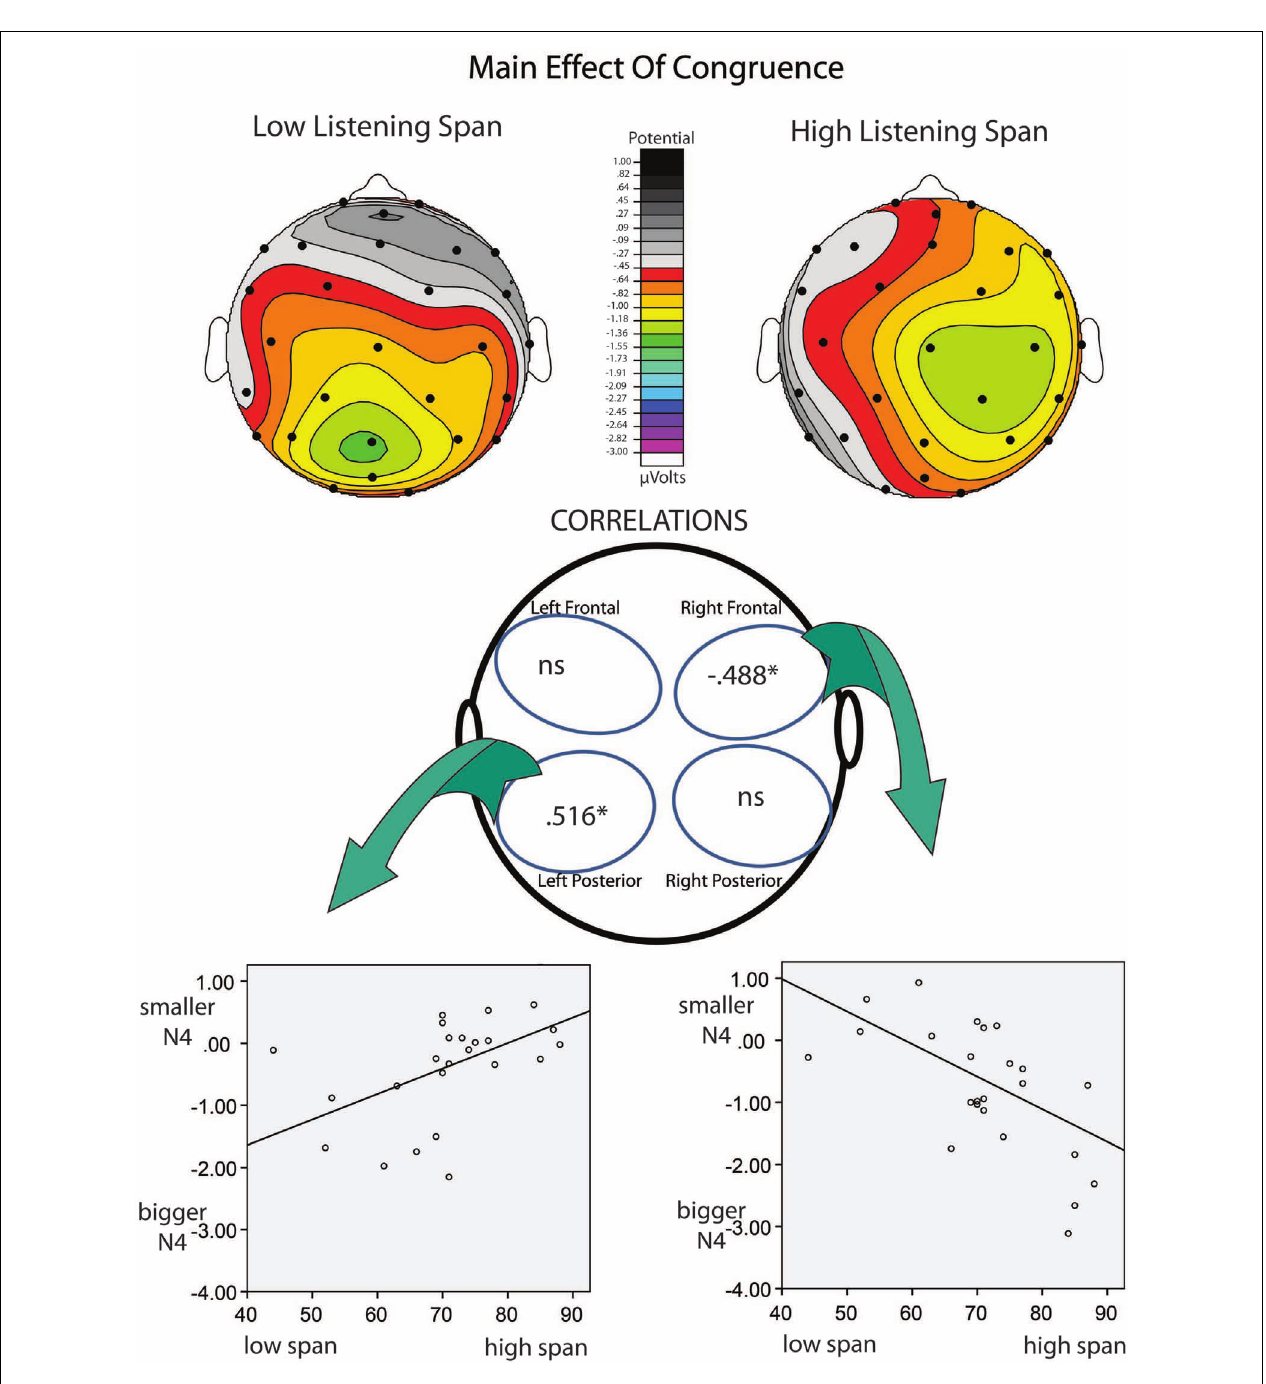
(left) and Low-Span participants (right). Correlations are shown at bottom. It is important to note that larger N400 effects are reflected by more negative